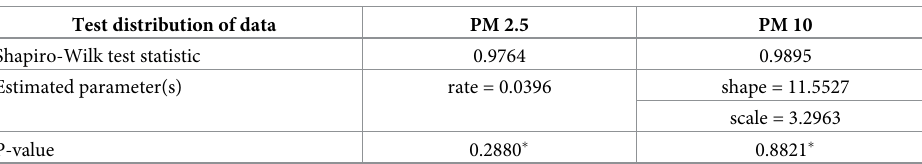
Table 5. Goodness-of-Fit test of real data.